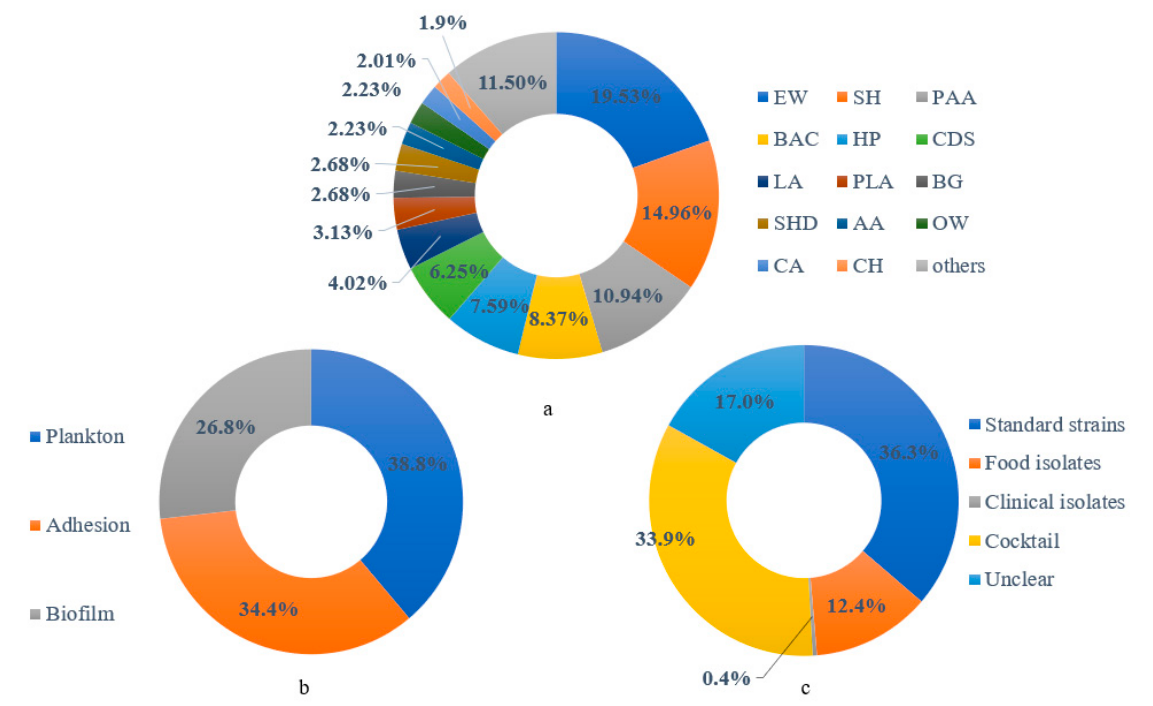
Figure 2. The proportion of ( a ) used sanitizers, ( b ) observed L. monocytogenes biofilm statuses, and ( c ) used L. monocytogenes strains extracted from the selected studies.